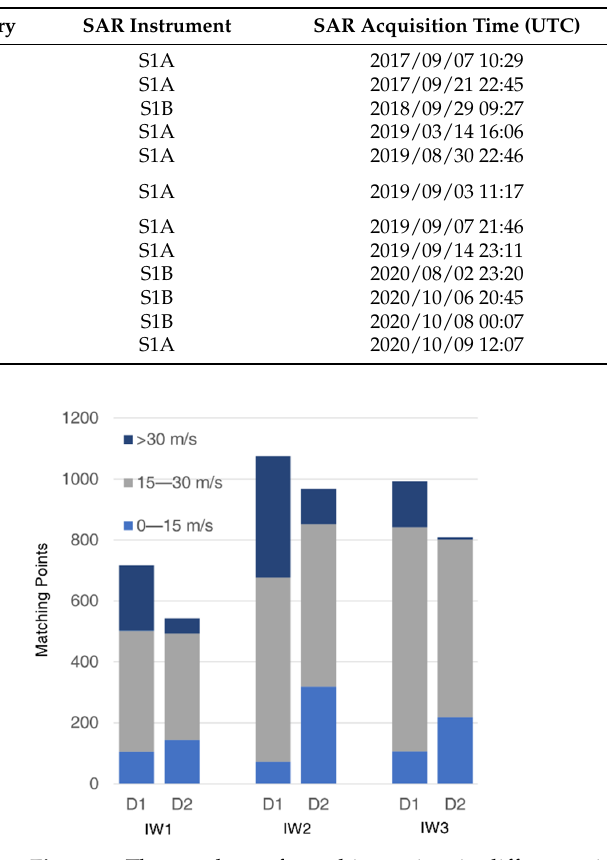
Figure 1. The numbers of matching points in different wind regimes and different sub-swaths. D1 and D2 are short for Dataset 1 and Dataset 2. IW1, IW2, and IW3 stand for sub-swath 1, sub-swath 2, and sub-swath 3, respectively. Table 1. Information of TCs, SAR images, and wind references.